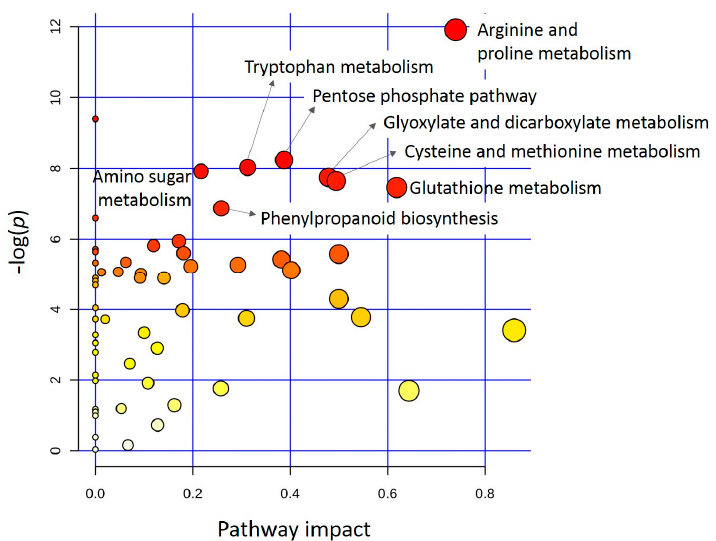
Figure 9. Metabolomics Pathway Analysis (MetPA) of grain tissue from the resistant Fhb7E (HOM+) vs. susceptible (HOM − ) lines at maturity, after inoculation with Fg . All the matched pathways are displayed as circles. The colour of each circle is based on p -values (darker colours indicate more significant changes of metabolites in the corresponding pathway), whereas the size of the circle corresponds to the pathway impact score. The most impacted pathways, having high statistical significance scores, are annotated by their full name.